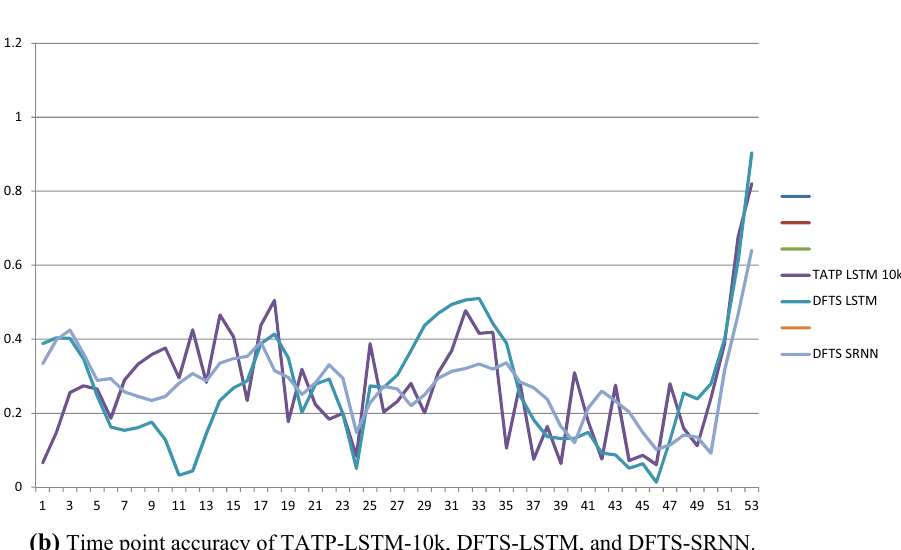
(b) Time point accuracy of TATP-LSTM-10k, DFTS-LSTM, and